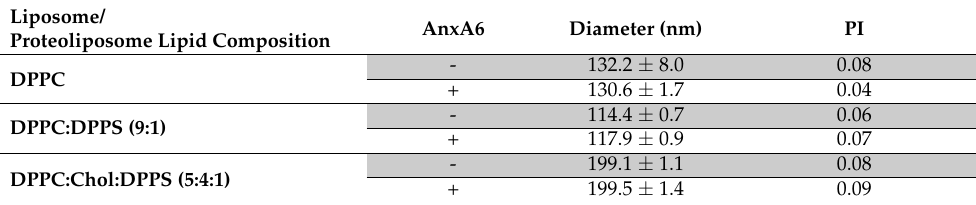
Table 1. Biophysical properties of liposomes and proteoliposomes constituted by different lipids. The diameters were obtained by DLS in triplicate assays, as described in Section 3, and PI is a polydispersion index. “-“ indicate the absence of AnxA6. Liposome/ AnxA6 Proteoliposome Lipid Composition